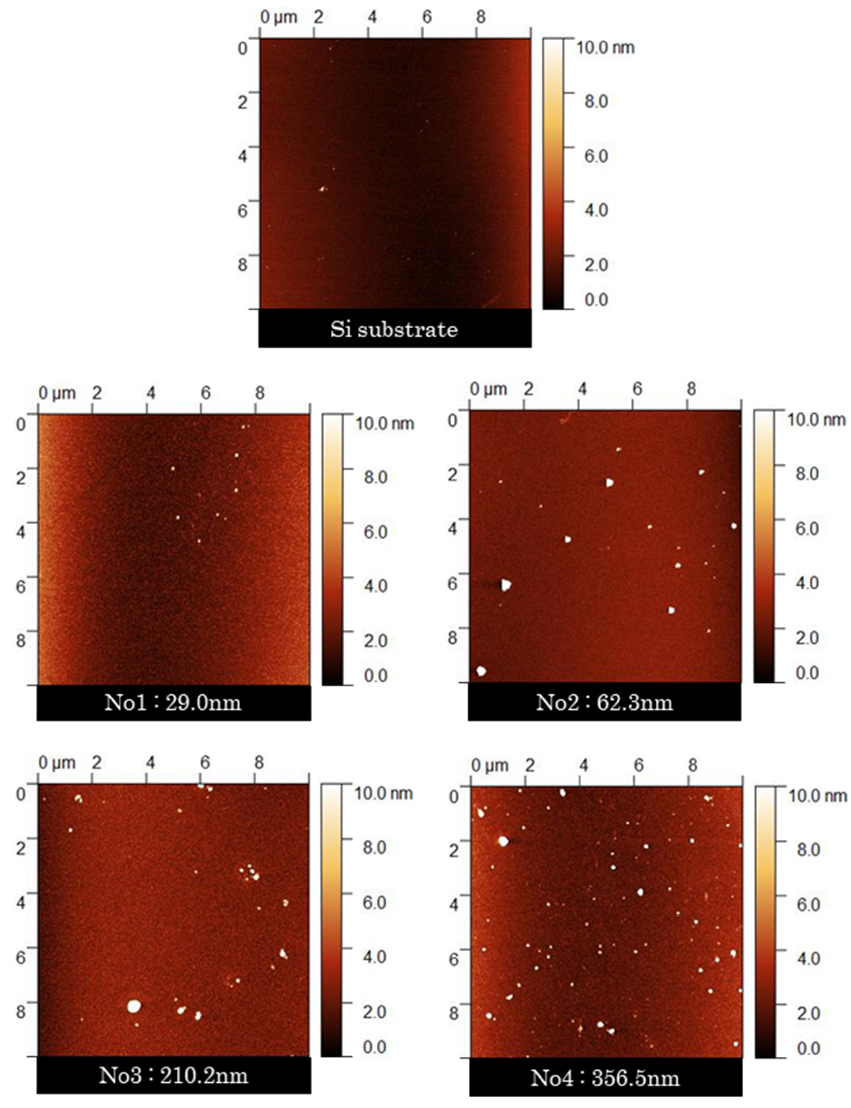
Figure 9. AFM images of the PLC samples.